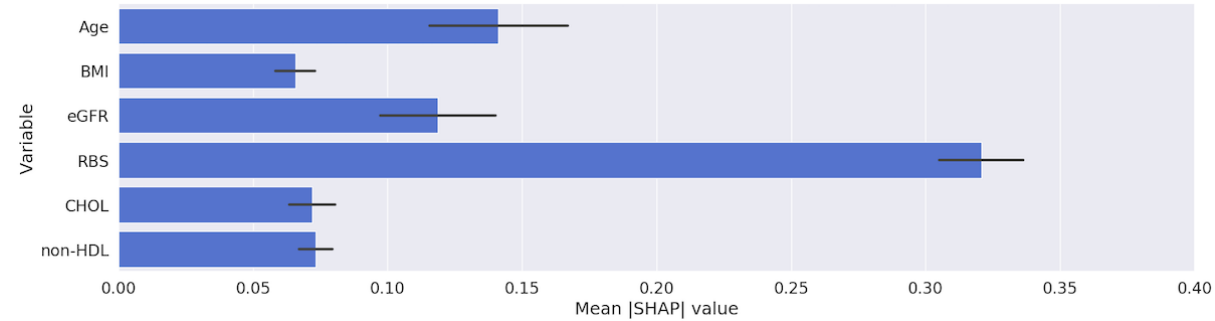
Figure 8. An example showing the SHAP values for a randomly selected sample with elevated glycated hemoglobin levels ( ≥ 5.7%). CHOL: total cholesterol; eGFR: estimated glomerular filtration rate; non-HDL: non–high-density lipoprotein; RBS: random blood sugar; SHAP: Shapley Additive Explanations.